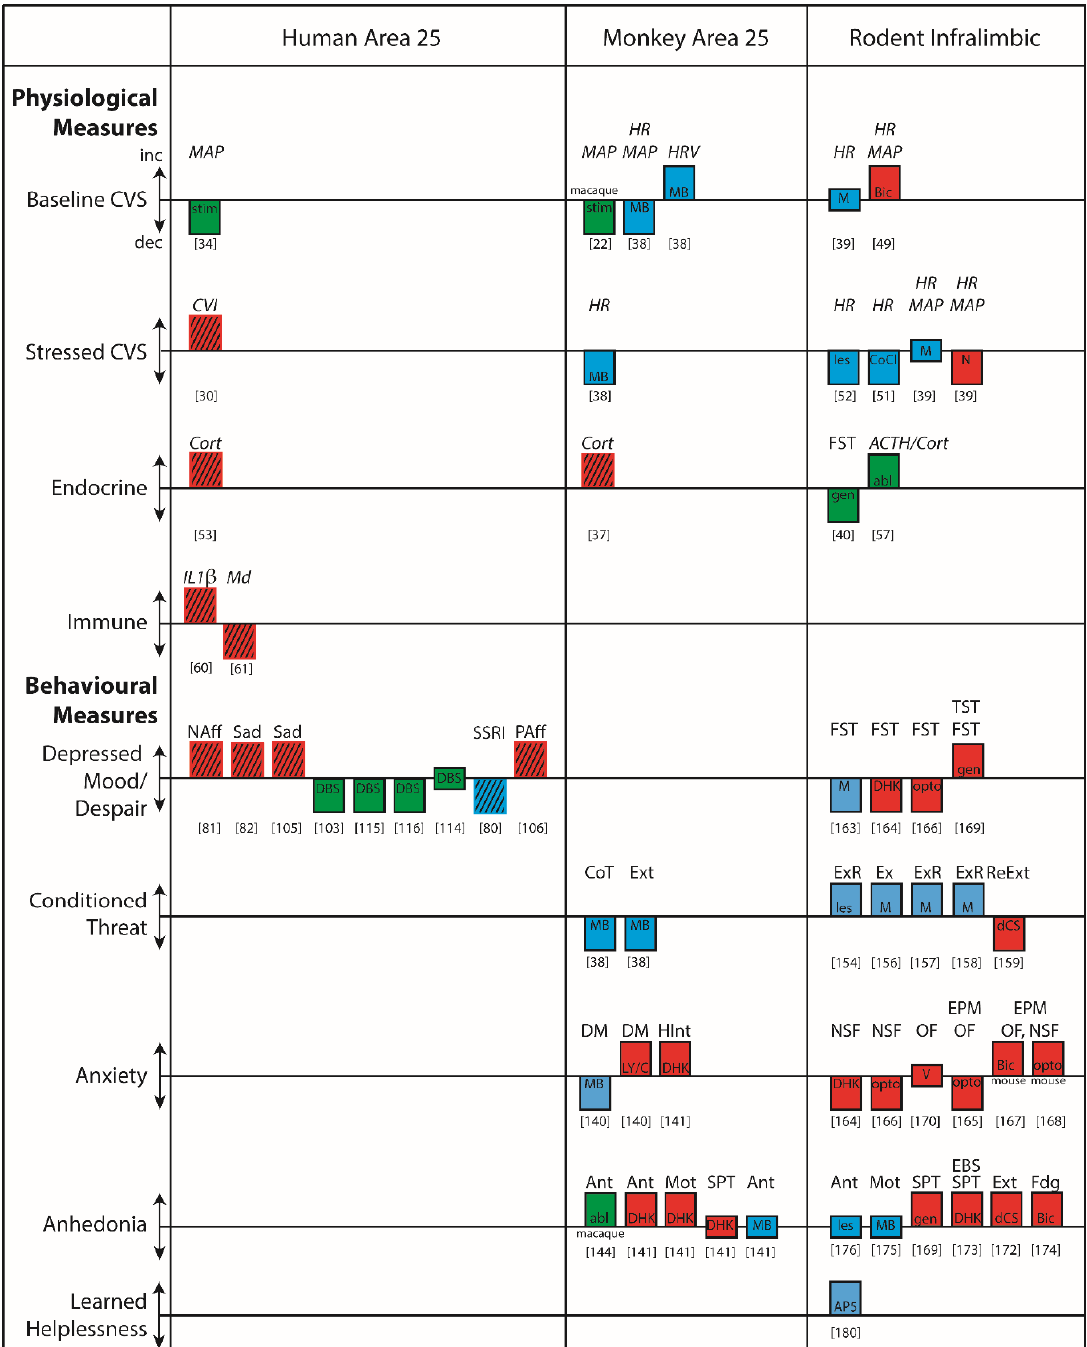
Figure 5. A summary of the physiological and behavioral functions associated with human and monkey area 25 and rodent infralimbic (IL). These representative studies illustrate, (i) the similarities and differences in the functional effects of manipulations of area 25 in monkeys and IL in rodents; (ii) how these map onto effects in humans; and (iii) where there are gaps in our knowledge. Blue bars denote reductions in activity, red bars denote increases in activity whilst green bars denote either that the direction of effects in area 25 are unclear, or that the effects may not be specific to area 25. Thus, if red and blue bars are going in the same direction (as in rodent despair), or if the same colored bars are going in opposite directions (as in rodent anxiety), the results are inconsistent. Headings above the bars indicate physiological measure if in italics, and the behavioral paradigm if non-italic. Hatching indicates correlations rather than manipulations. In terms of physiology, there is reasonable correspondence between monkey and rodent with respect to the reductions/increases in cardiovascular activity following reductions/increases in area 25/IL activity, especially during stress;